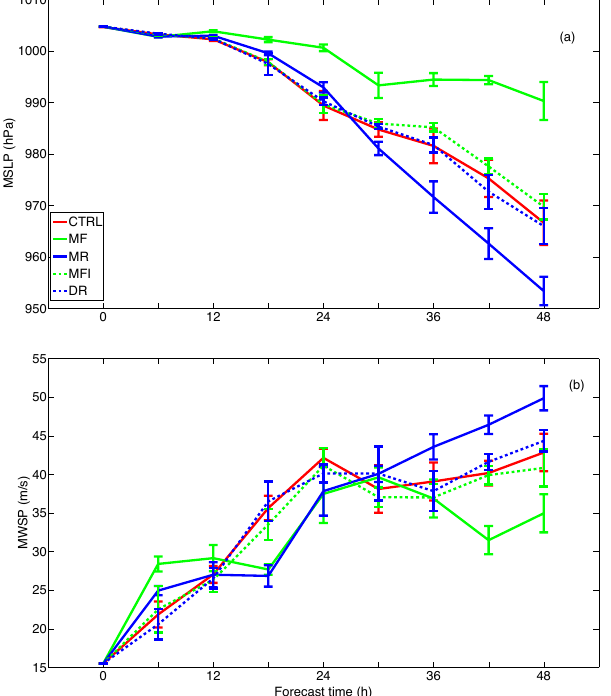
Figure 2. Time series of the model simulated ensemble mean and standard deviation of (a) MSLP (hPa) and (b) MWSP (ms − 1 ) .